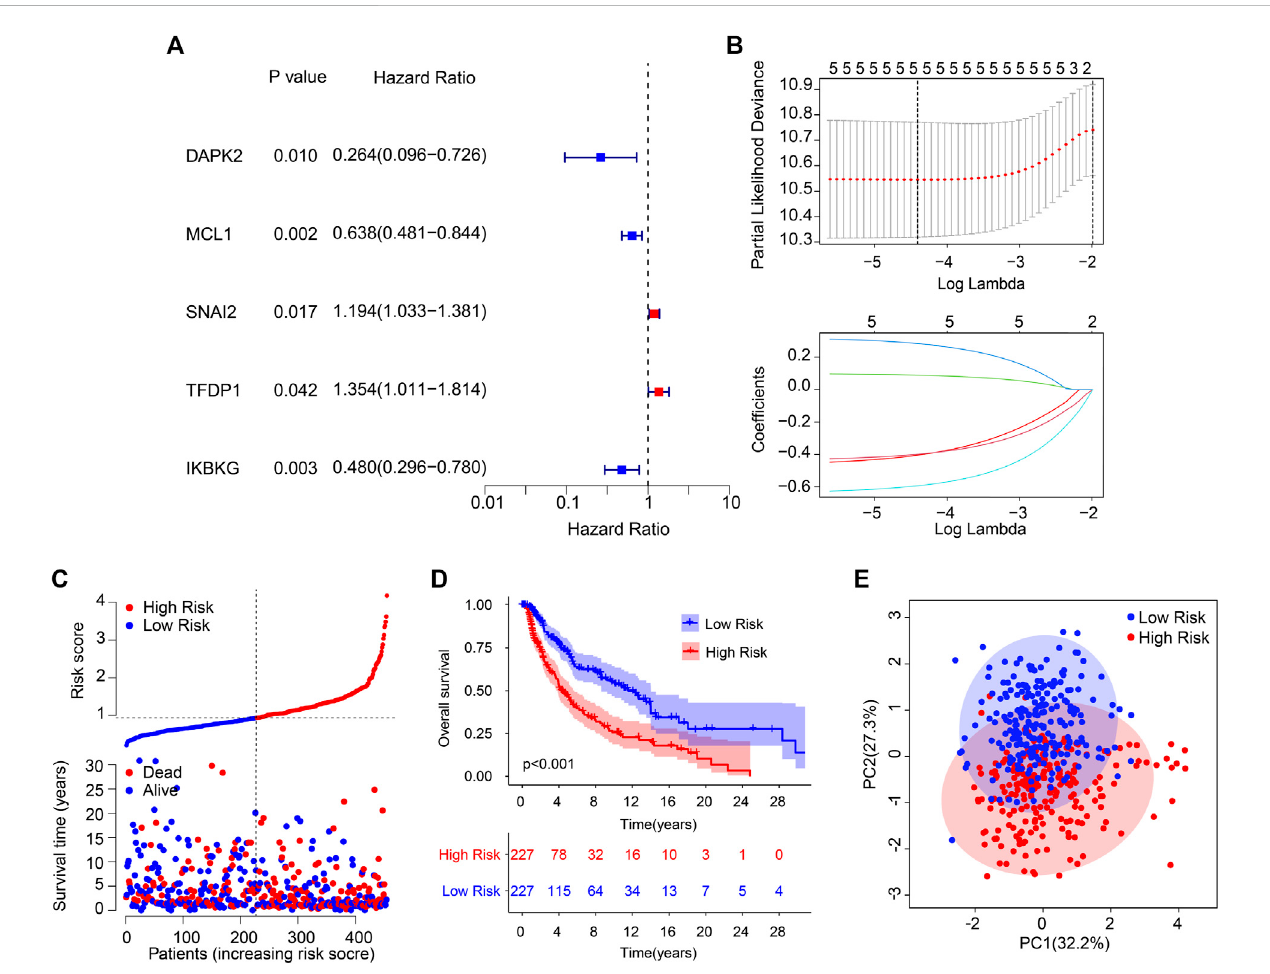
FIGURE 1 Risk model construction based on the prognostic ARGs in CM. (A) Identi fi cation of prognostic ARGs via the univariate Cox regression analysis. (B) The resultofLASSOregressionanalysis. (C) TheKaplan – Meiersurvivalcurveindicatesthatthelow-riskscorepatientshavehigherOSrates. (D) Theclassi fi cationof the CM patients according to the ARG prognostic signatures and the scatter dot plot reveals the correlation between the ARG prognostic signatures and survival time. (E) A clear distribution between the different risk groups is revealed by principal component